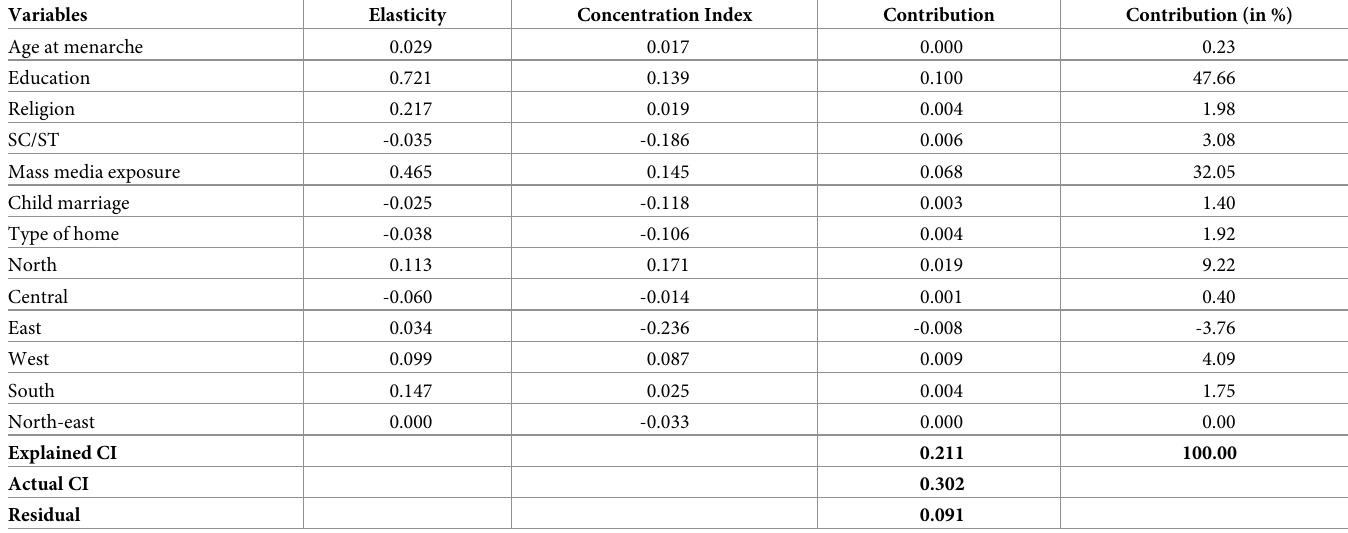
Table 3. Decomposition of wealth-based inequality in the exclusive use of hygienic materials among urban women aged 15–24 years, NFHS-5, 2019–21. Variables Elasticity Concentration Index Contribution Contribution (in